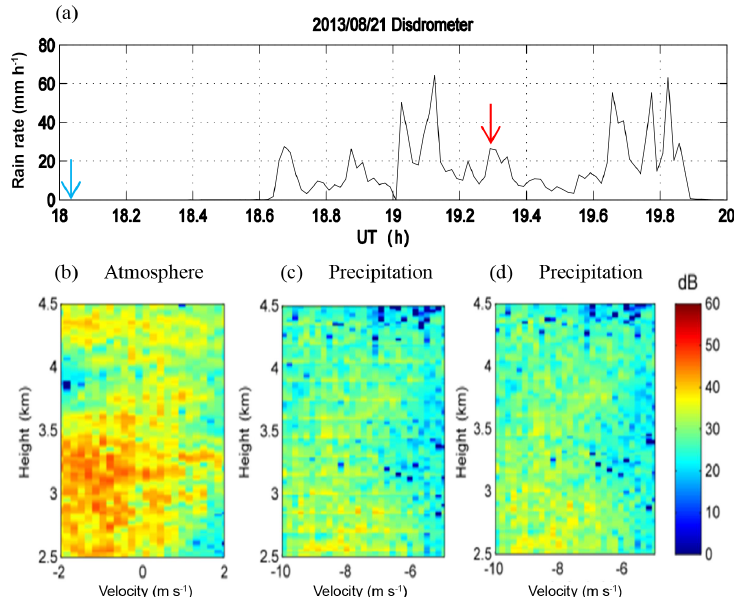
Figure 3. (a) Rain rate detected by a disdrometer. Panels (b, c) are, respectively, power spectra of atmosphere and precipitation echoes at the moment indicated by the red arrow in (a) . A constant range delay is used for correction. (d) Same as (c) but with point-by-point correction of range delay.